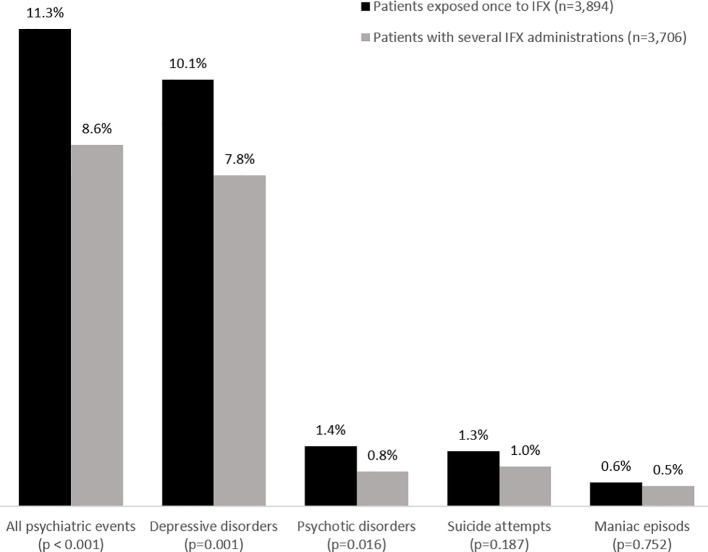
Psychiatric outcomes as a function of the number of prior infliximab administrations.